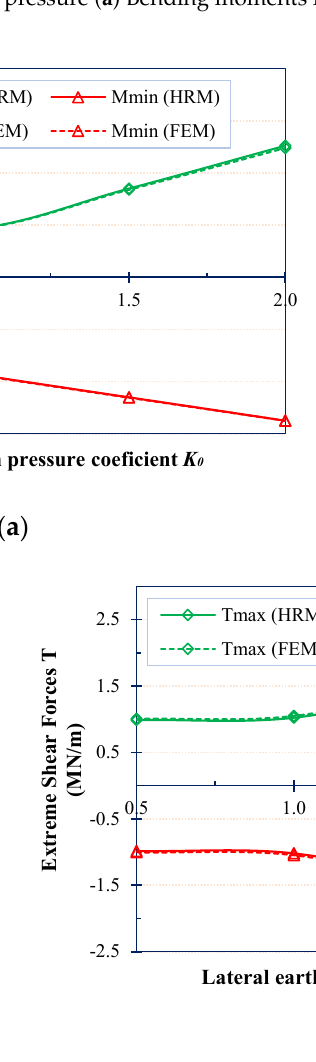
Figure 8. Internal forces in the squared tunnel lining with different coefficients of lateral earth pressure ( a ) Bending moments M; ( b ) Normal forces N; ( c ) Shear forces T.